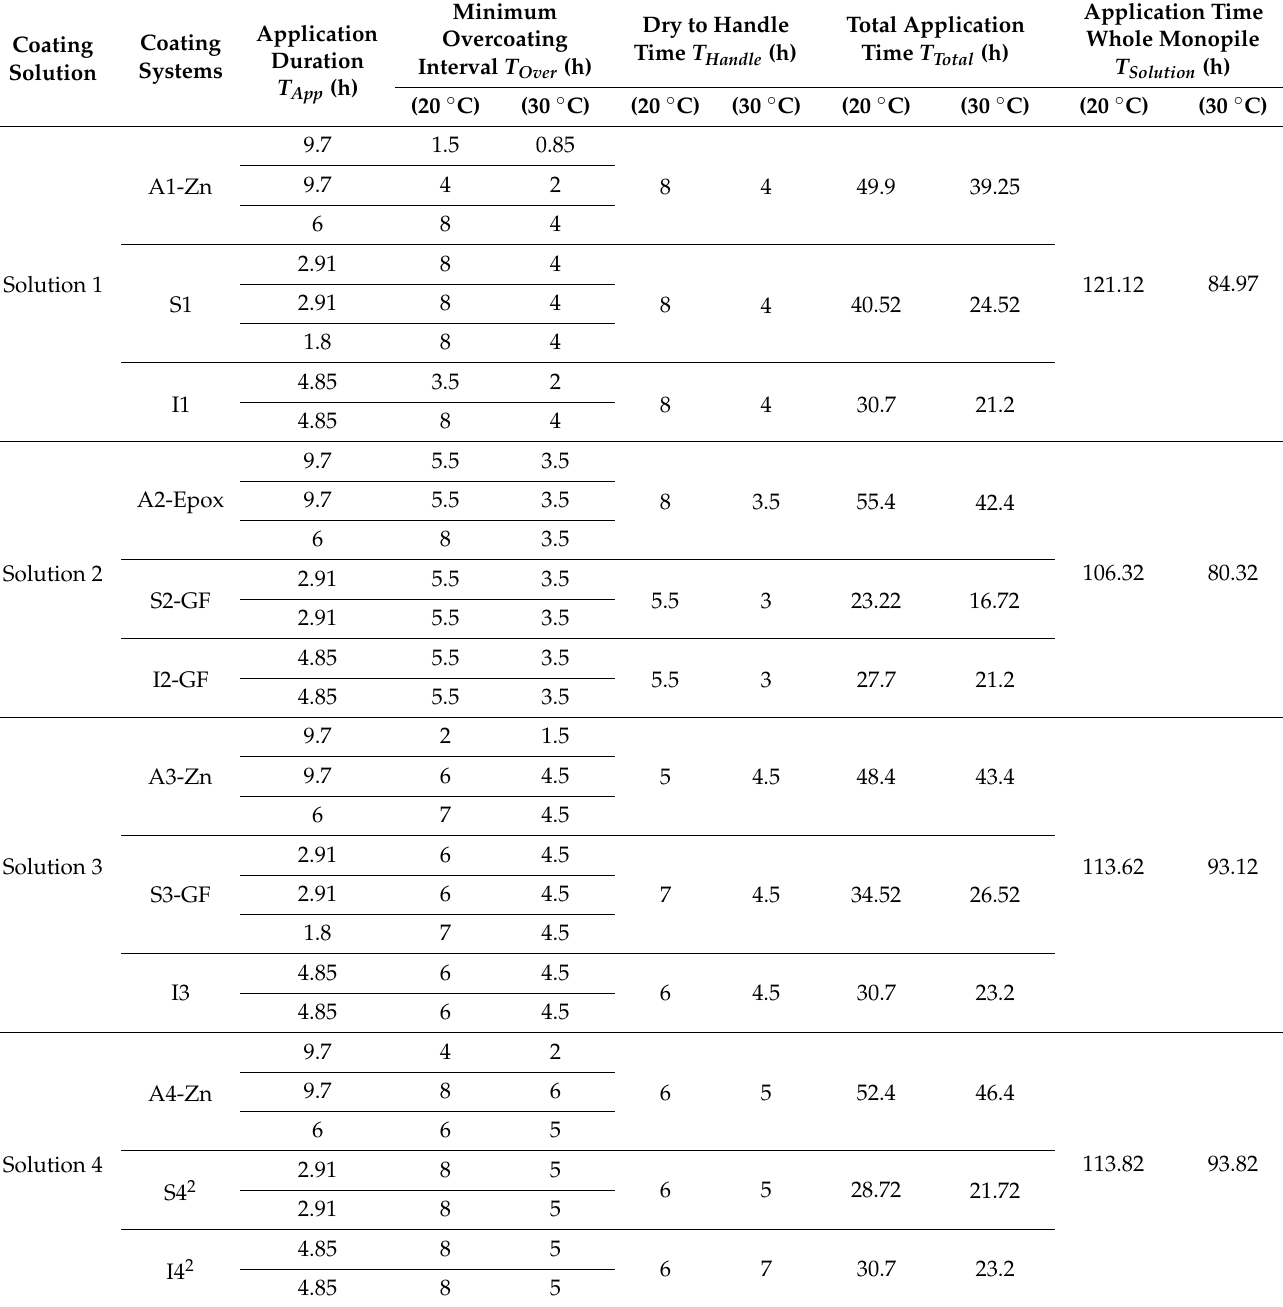
Table 12. Parameters of the coatings related to their application